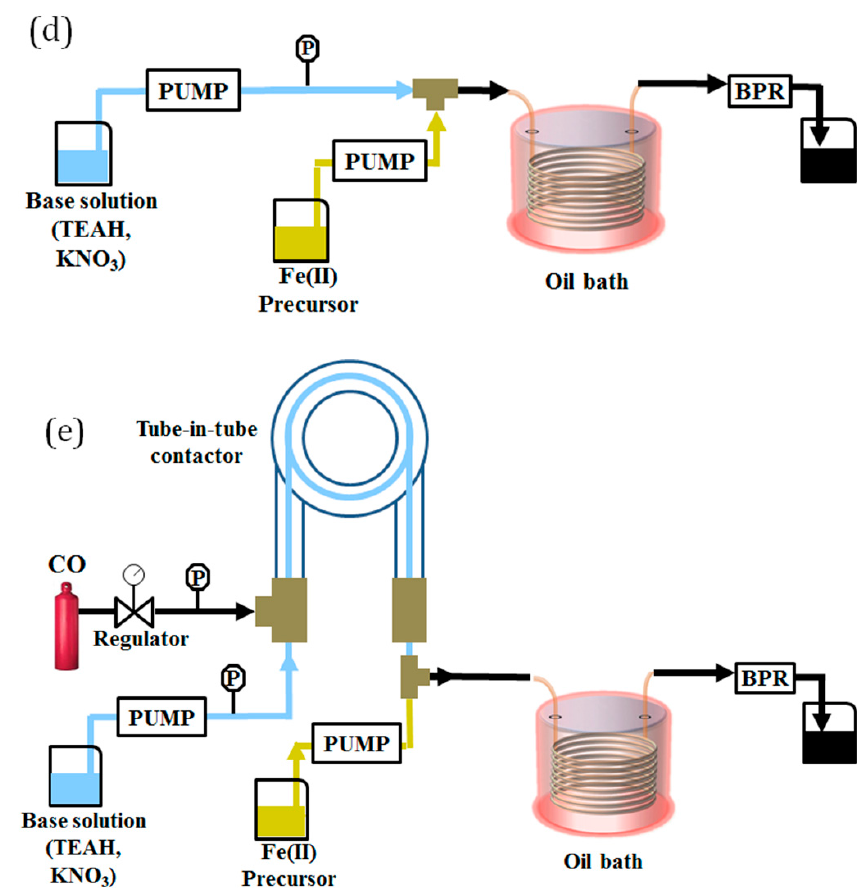
Figure 1. ( a ) Schematic describing the working principle of a tube-in-tube gas–liquid contactor. ( b – e ) Schematics of the setups employed for the flow synthesis. ( b ) Reactor System 1, segmented flow reactor with solutions preventively bubbled with N 2 ; ( c ) Reactor System 2, segmented flow reactor with H 2 -saturated heptane; ( d ) Reactor System 3, single-phase reactor with solutions preventively bubbled with N 2 ; ( e ) Reactor System 4, single-phase reactor with CO-saturated base